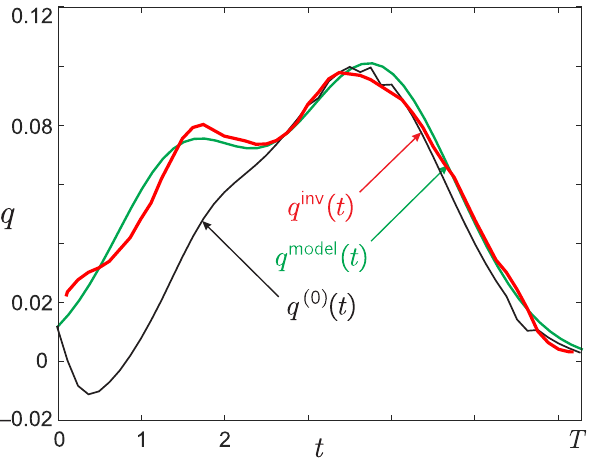
Figure 8. Result of restoring the function q inv ( x ) using the gradient method of minimizing the ( t ) , simulated for a set of model parameters (10), ( t ) and f target functional (12). The functions f 1 2 δ 2 δ 1 ε = 10 − 1 , and errors { δ 1 , δ 2 } = { 0,7.15 × 10 − 2 } (matches “ δ 1 “ = 0% and “ δ 2 “ = 75%). The gradient method was started with a “good” initial approximation q ( 0 ) ( t ) , which coincides in the case of the selected errors with those shown in Figure 6a.